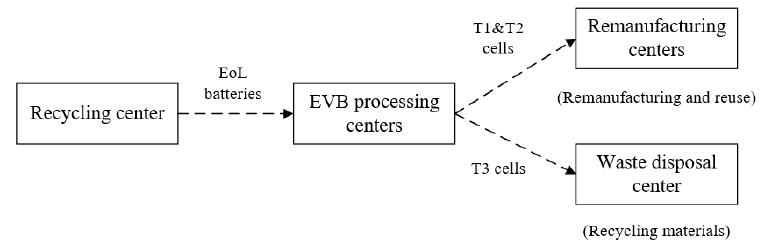
Figure 1. EVB recycling network.